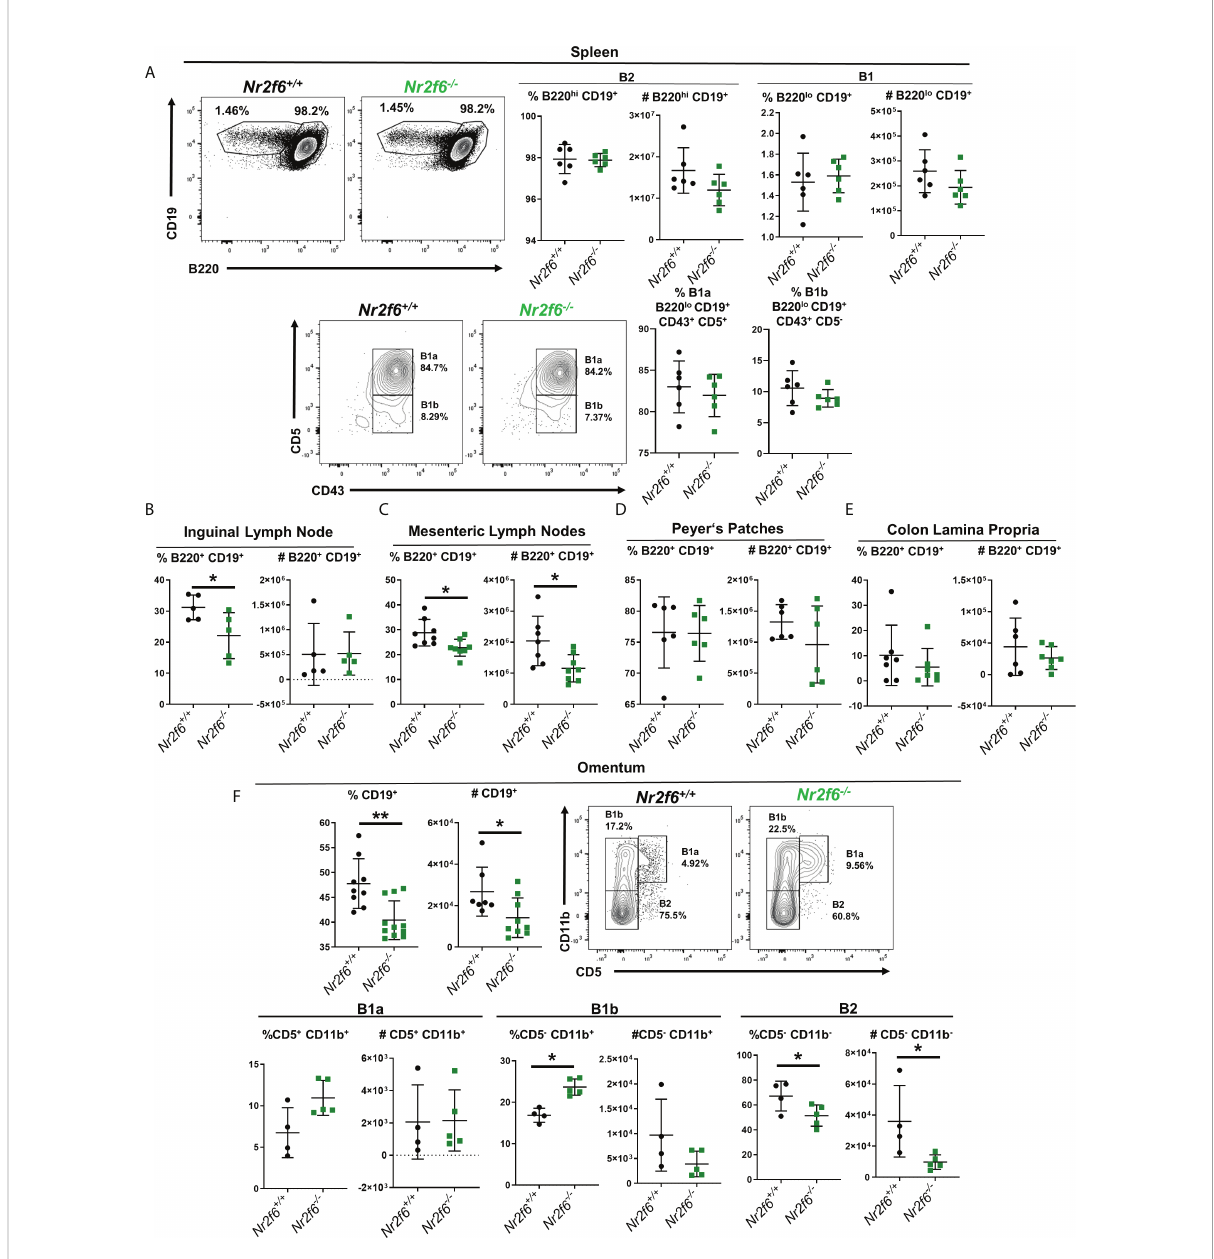
FIGURE 3 B cells are reduced in the mesenteric lymph nodes and omentum in the absence of NR2F6. Flow cytometry analysis of B cells at multiple locations of Nr2f6 -suf fi cient and – de fi cient mice. (A) B1 and B2 populations in the spleen were determined by labeling of B220 and CD19 as indicated. Cell numbers were calculated from the fl ow cytometry data. B1a and B1b cells were further de fi ned by CD43 and CD5 expression (lower row). (B, C) B cells in indicated lymph nodes were stained for B220 and CD19 and frequency was used to determine total B2 cell numbers. Lymph node data is based on a single inguinal lymph node, while mesenteric lymph node numbers are derived from the total mesenteric lymph nodes in each mouse. (D) Peyer ’ s patches were removed from the small intestine a total of six were pooled per mouse and stained for CD19 and B220 to determine B cell numbers. (E) Colons were disgested and fi ltered and B cells were identi fi ed by CD19 and B220 staining. (F) Lymphocytes were isolated from the ommentum by physical disruption and total B cells were enumerated by CD19 staining. B1a, B1b and B2 cells were de fi ned from CD19 + cells by CD11b and CD5 staining (lower row). Each data point represents an individual mouse, data shown are from at least two individual experiments with at least two mice of each genotype per experiment. For most data sets statistical signi fi cance was determined using a two-tailed student t-test however, all data were tested for normality by Shapiro-Wilk testing, and for non- normally distributed data, signi fi cance was determined using a Mann-Whitney U test. Within this fi gure, (B) total CD19 + B220 + and (F) CD19% in the omentum were not normally distributed and were tested for signi fi cance by a Mann-Whitney U test, signi fi cant p-values for all tests are displayed as *<0.05 and